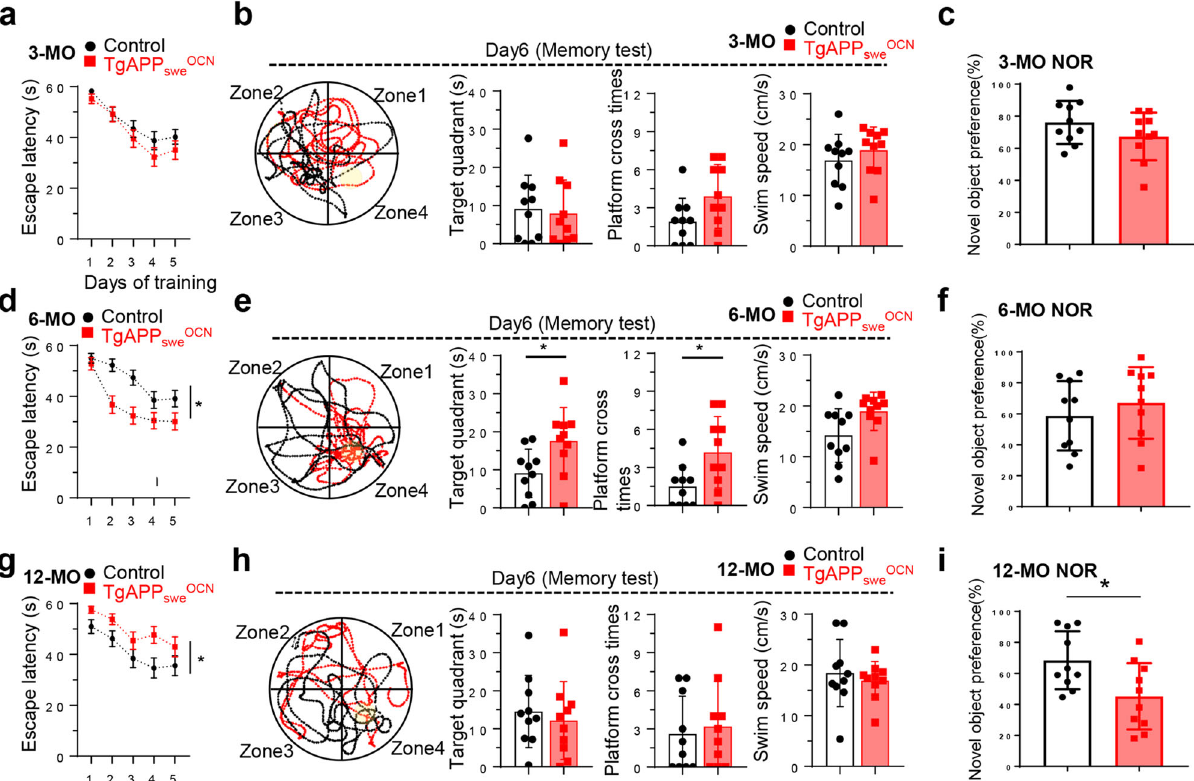
Fig. 4 Age-dependent alterations in spatial learning and memory in TgAPP swe OCN mice. a – c 3-MO control ( LSL-APP swe ) and TgAPP swe OCN male mice were subject to Morris water maze (MWM) ( a , b ) and Novel Object Recognition (NOR) ( c ) tests. d – f 6-MO control ( LSL-APP swe ) and TgAPP swe OCN male mice were subject to MWM ( d , e ) and NOR ( f ) tests. g – i 12-MO control ( LSL-APP swe ) and TgAPP swe OCN male mice were subject to MWM ( g , h )